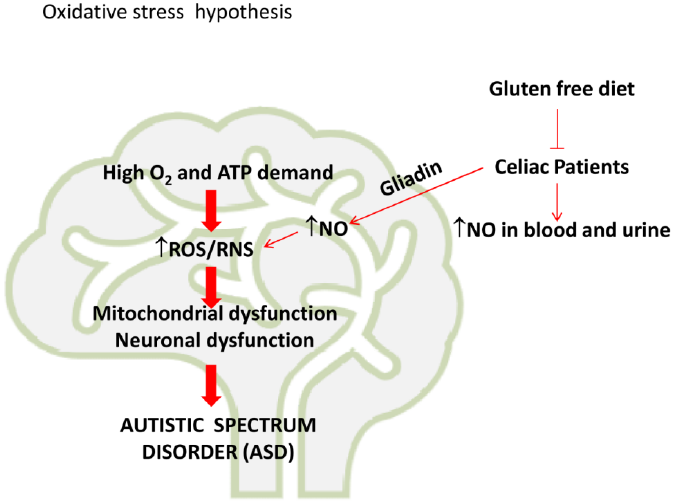
Figure 2. “Oxidative hypothesis”. The elevated oxygen consumption in brain favors ROS / RNS production. This induces mitochondrial and neuronal dysfunctions which could contribute to the development of Autistic Spectrum Disease. In celiac patients, gluten-derived peptides, such as gliadin, increase NO production and oxidative / nitrosative stress in brain. These events could contribute to the development of Autistic Spectrum Disorders in celiac